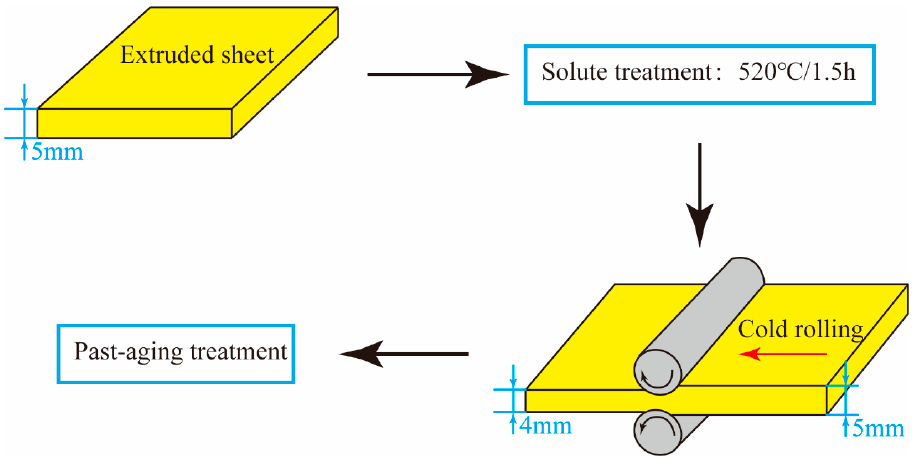
Figure 1. The sketch map of the experimental procedure.